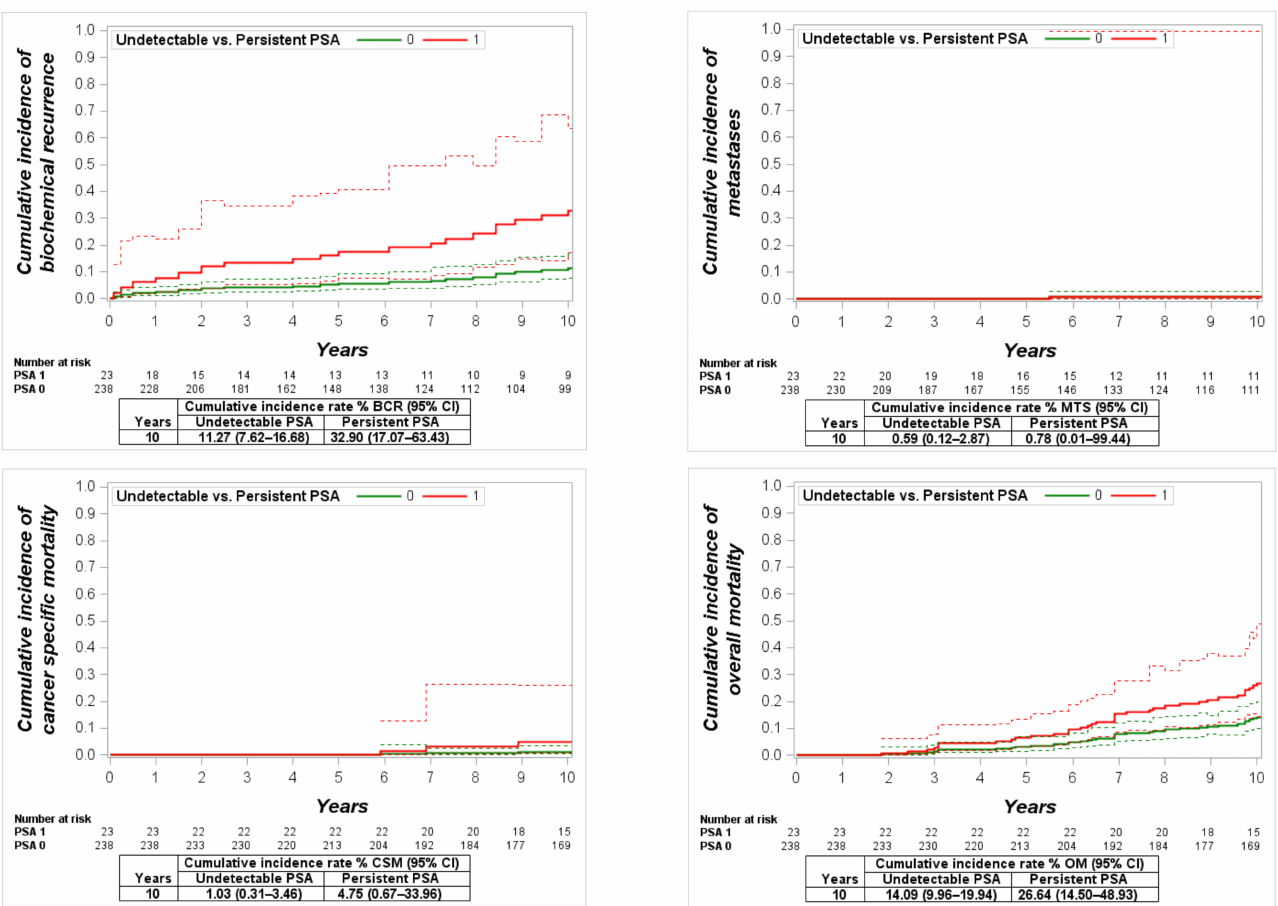
Figure 3. Cumulative incidence function for biochemical recurrence (BCR), metastases (MTS), cancer-specific mortality(CSM) and overall mortality (OM) in low-risk patients with undetectable vs. persistent prostate-specific antigen